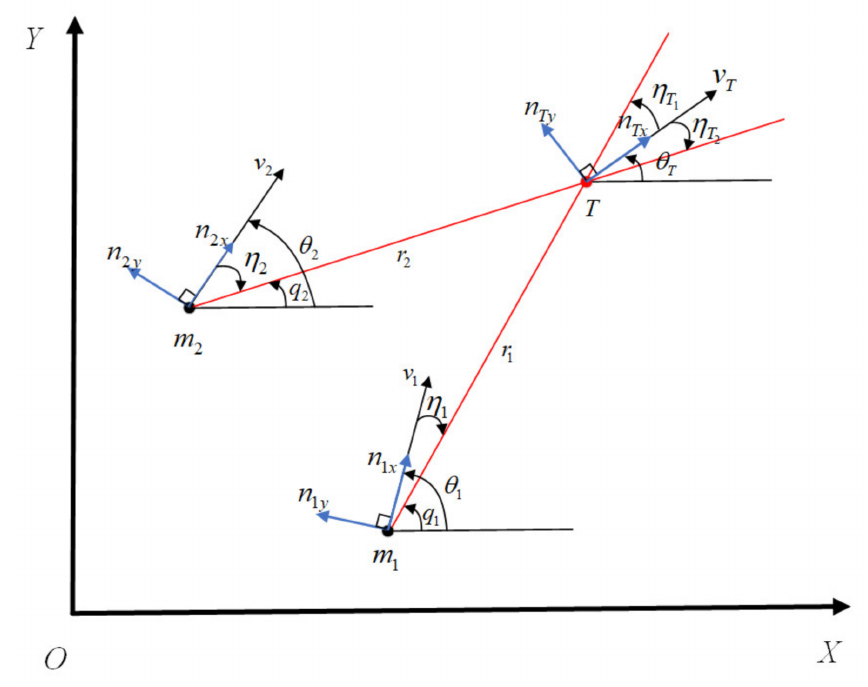
Figure 1. The geometric relationship between multiple UAVs and